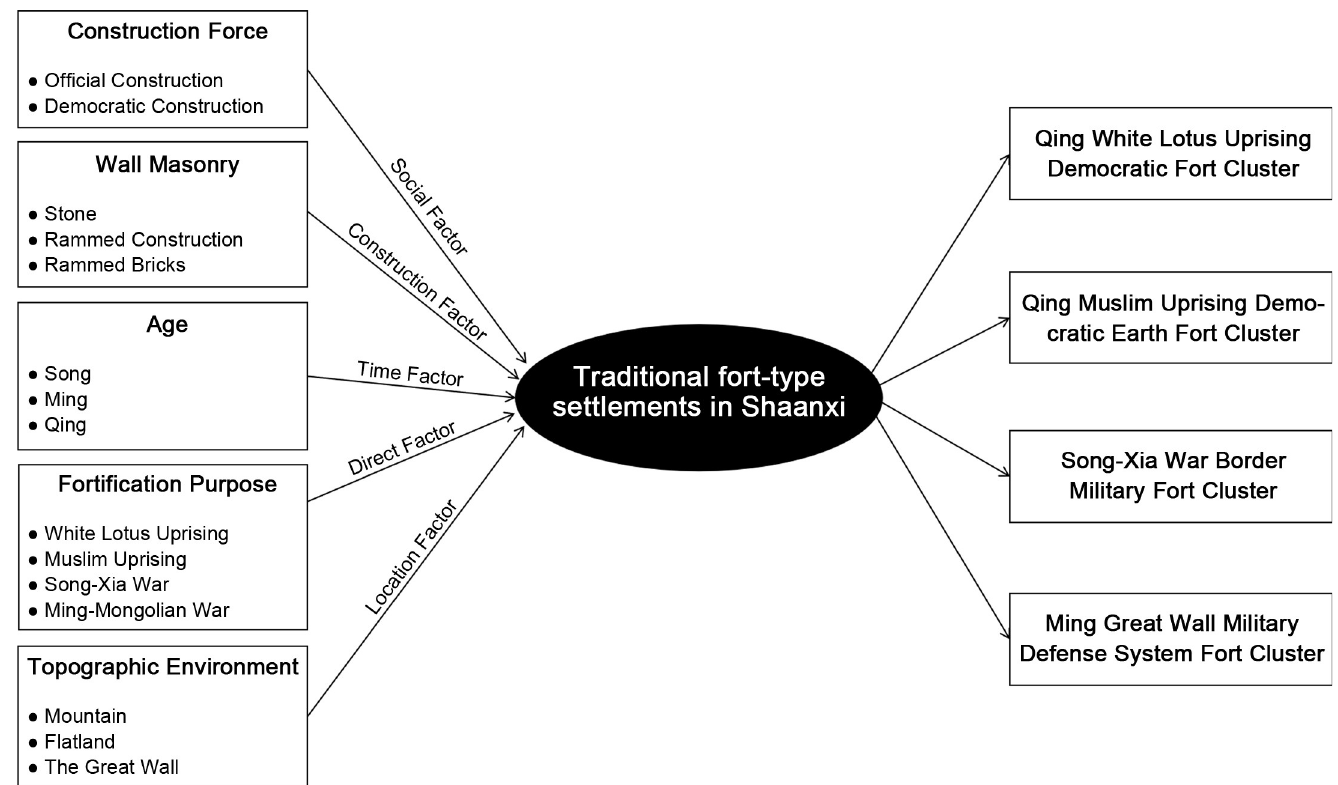
Fig 18. Influencing factors action process.